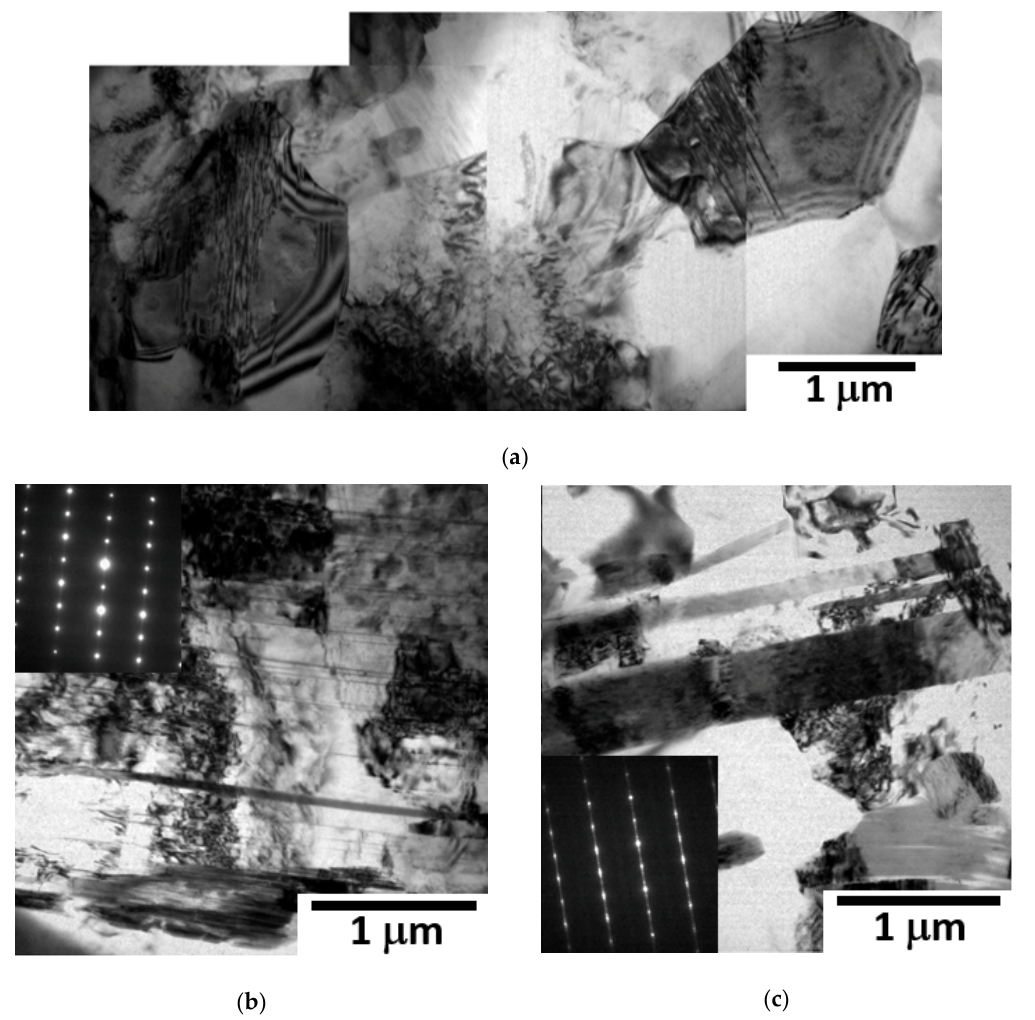
Figure 7. Bright field TEM images and SAED pattern of the extruded GWZ831 alloy of the ( a ) DRXed grains, ( b ) non-DRXed grains (B = [11 2(cid:3364) 0]), and ( c ) LPSO phase (B = [ 112(cid:3364)0 ]).